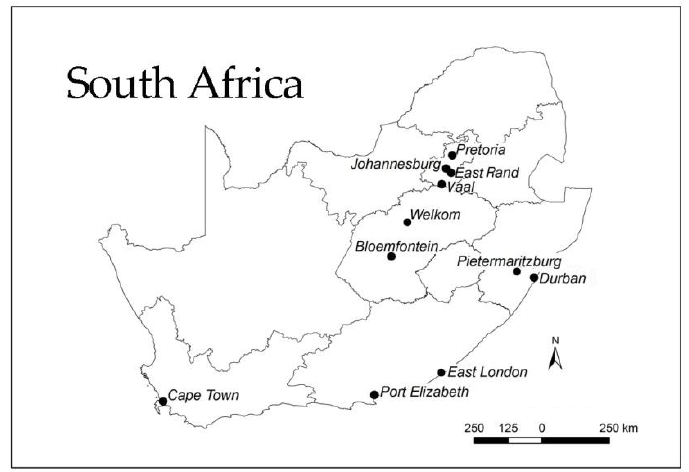
Figure 2. Metropolitan areas and cities included in the study.